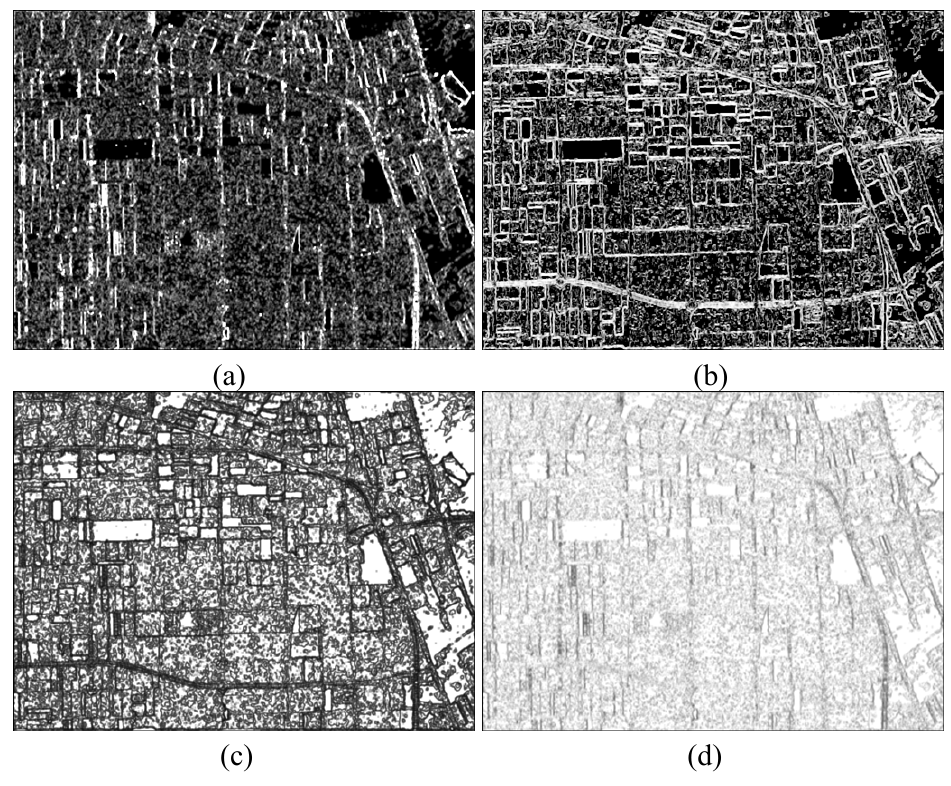
. ( a ) Contrast; ( b ) Correlation; ( c ) Energy; ( d ) Homogeneity. 22